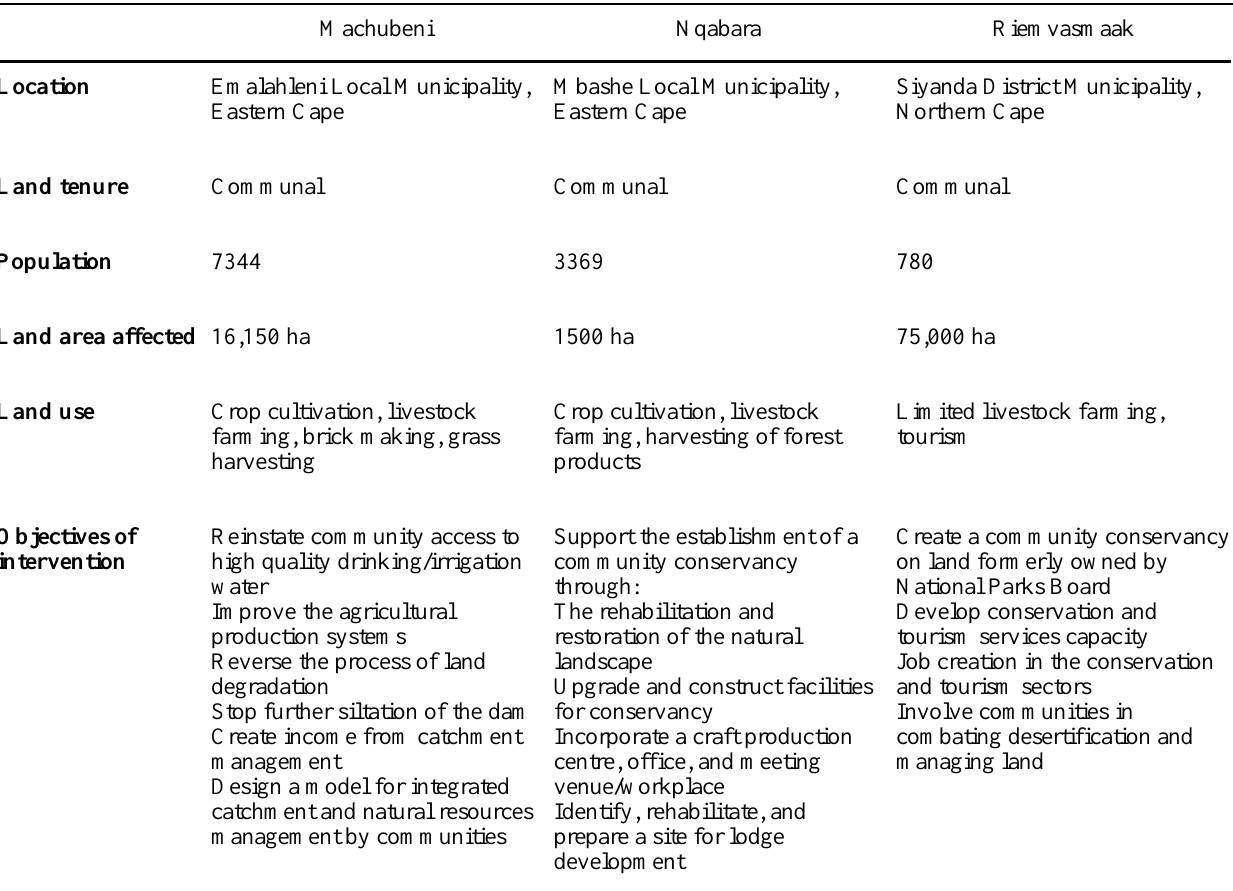
Table 3 . Case study